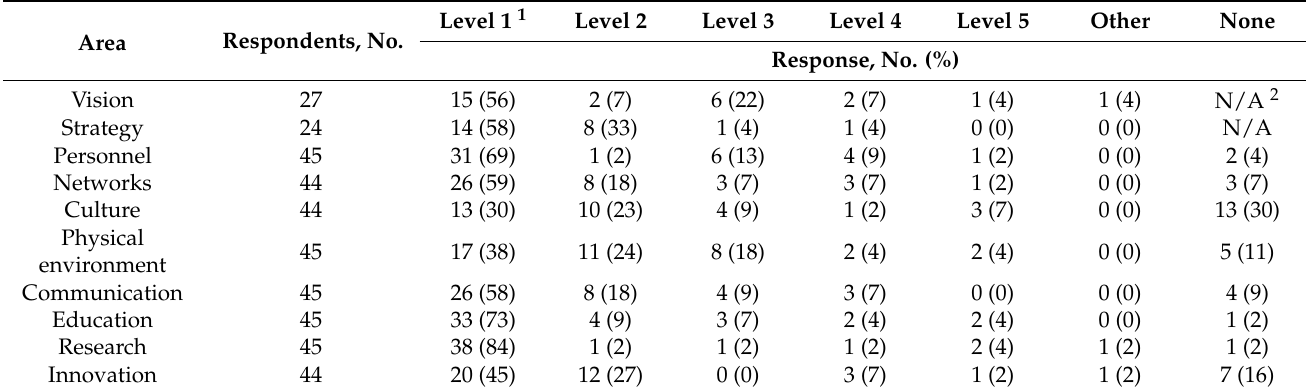
Table 3. Climate action at different